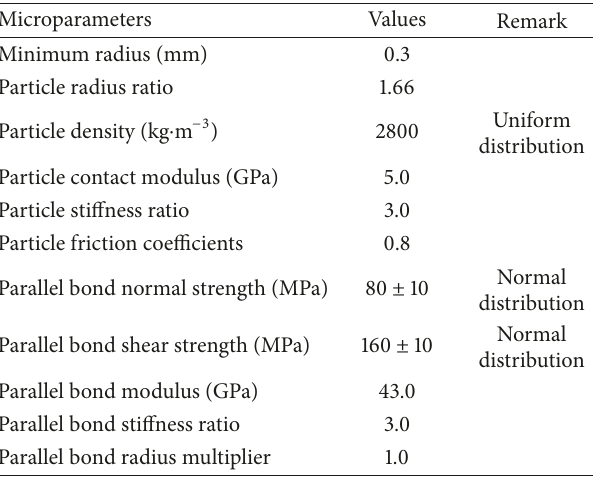
Table 1: Microparameters of the rock